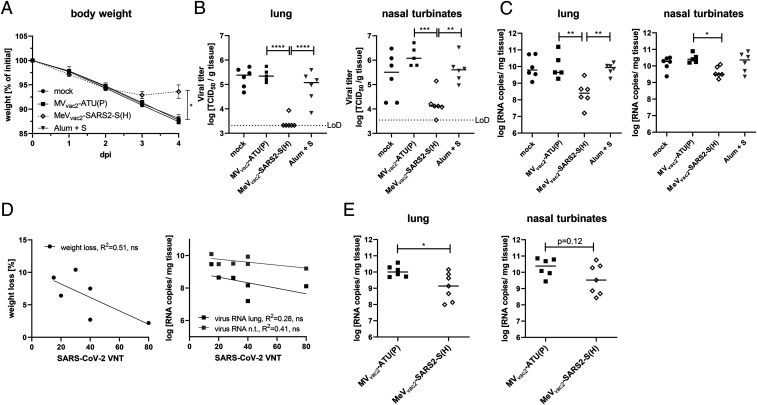
Vaccine efficacy in Syrian hamster and mouse challenge models. Fully immunized Syrian golden hamsters (A–D) and IFNAR−/−-CD46Ge mice (E) were intranasally challenged with SARS-CoV-2 or mouse-adapted SARS-CoV-2 MA, respectively, and protection was analyzed by quantifying weight loss (A), live virus titration in lungs or nasal turbinates (B), or SARS-2 E gene copy numbers via qRT-PCR (C and E). The limit of detection (LoD) is indicated. (D) For the correlation analysis comparing humoral immunity (VNT) of hamsters vaccinated with MeVvac2-SARS2-S(H) on days 0 and 21 (sampled on day 35) and challenge outcome, linear regression was performed with the indicated challenge outcome parameters to determine Pearson correlation coefficient (R2). For statistical analysis of hamster data, one-way ANOVA was performed in combination with Tukey’s multicomparison test to compare all pair means. For comparison of mouse data between the two groups, unpaired two-tailed t test was applied; ns, not significant; (P > 0.05); *P < 0.05; **P < 0.01; ***P < 0.001; ****P < 0.0001.